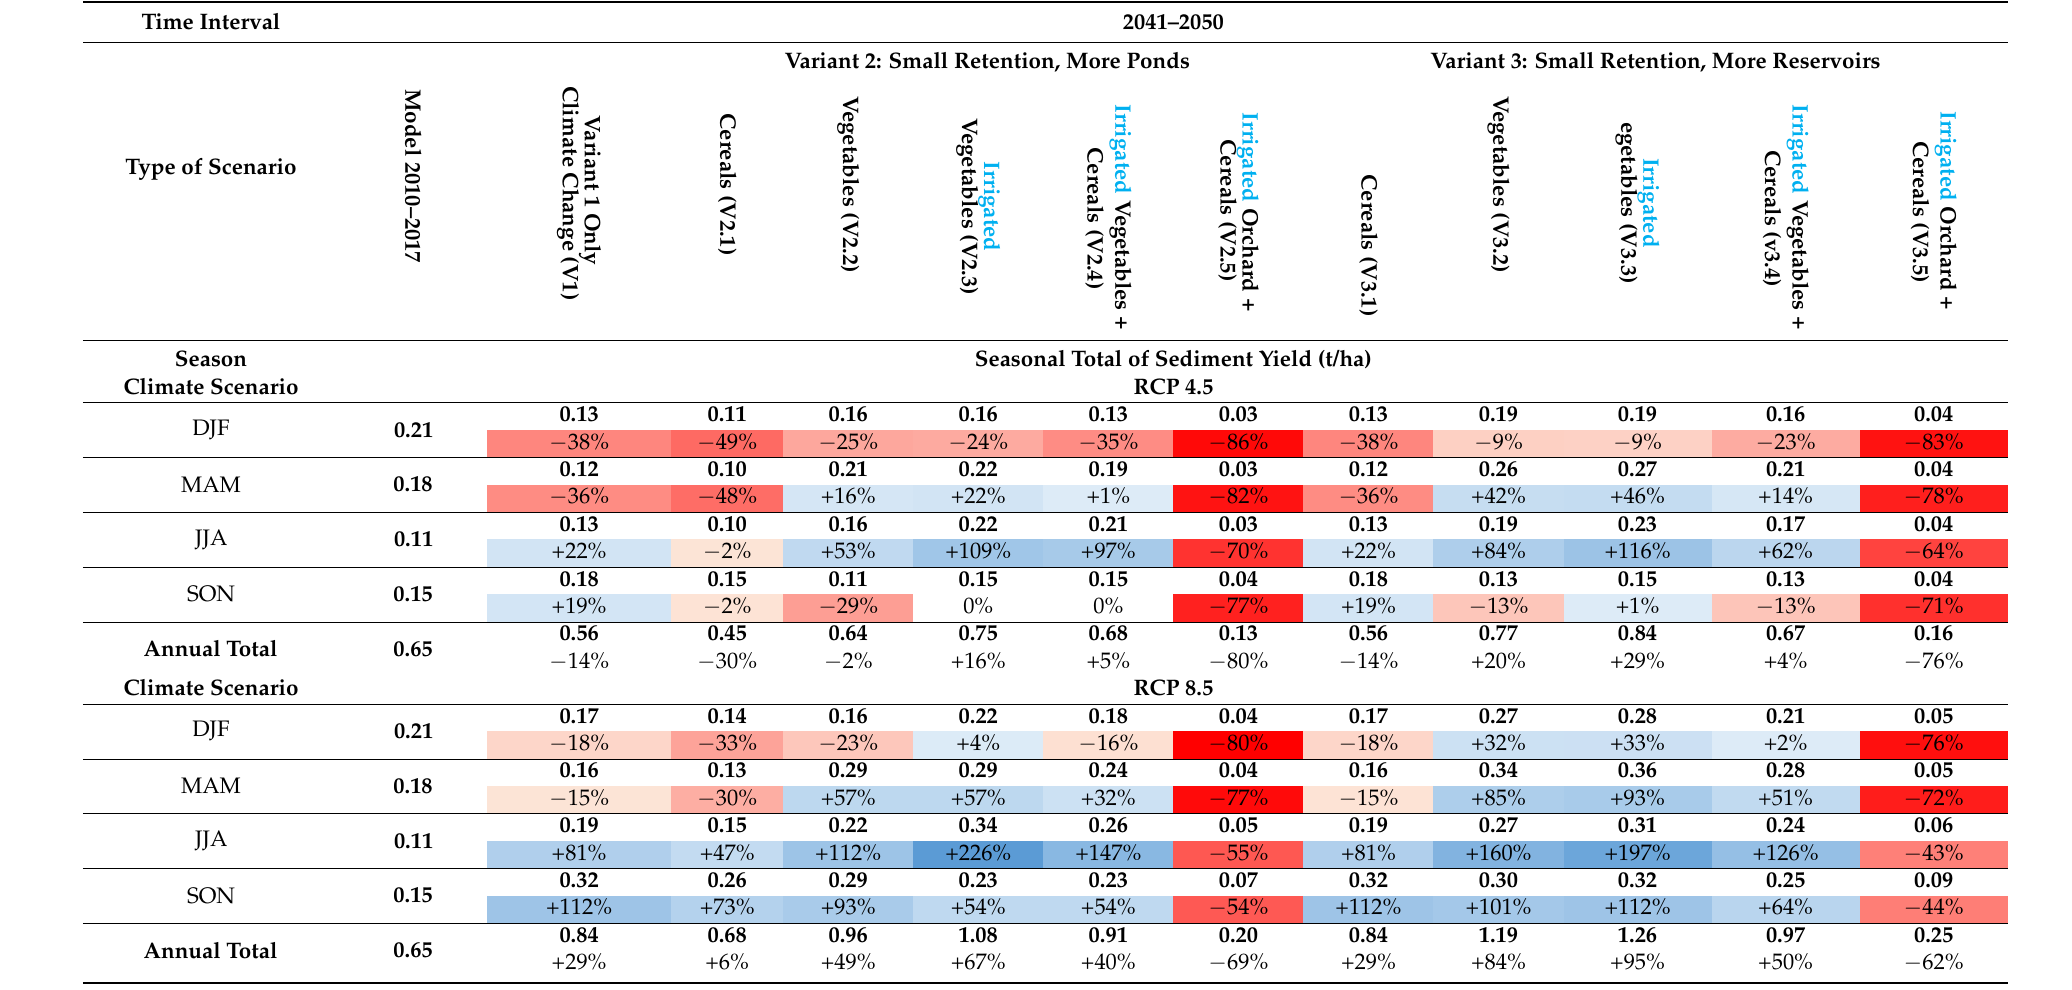
Table 6. Average sediment yield in the Bystra catchment for DJF (December, January, February, etc.), MAM, JJA and SON in 2041–2050 under various scenarios (SWAT model, V1, V2.1-V2.5 and V3.1-V3.5) for climate scenarios RCP 4.5 and RCP 8.5. Numbers in red (decreases) or blue (increases) refer to a percentage change in the water content in soil (bold numbers) (author’s own